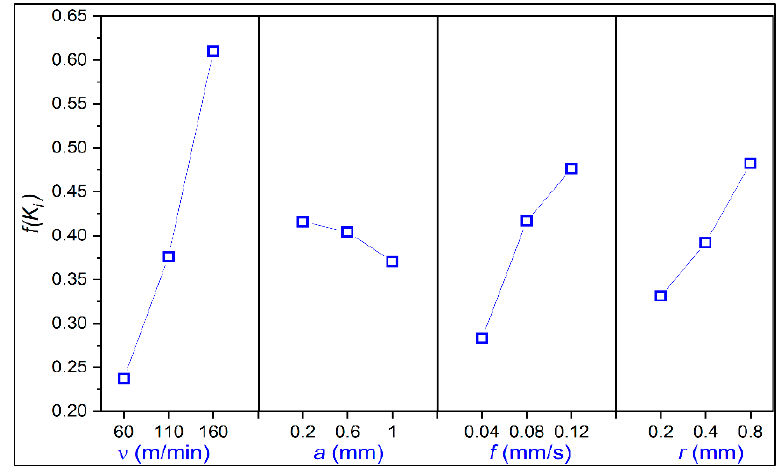
Figure 2. Level-wise aggregated f (K_i) score for each process parameter.